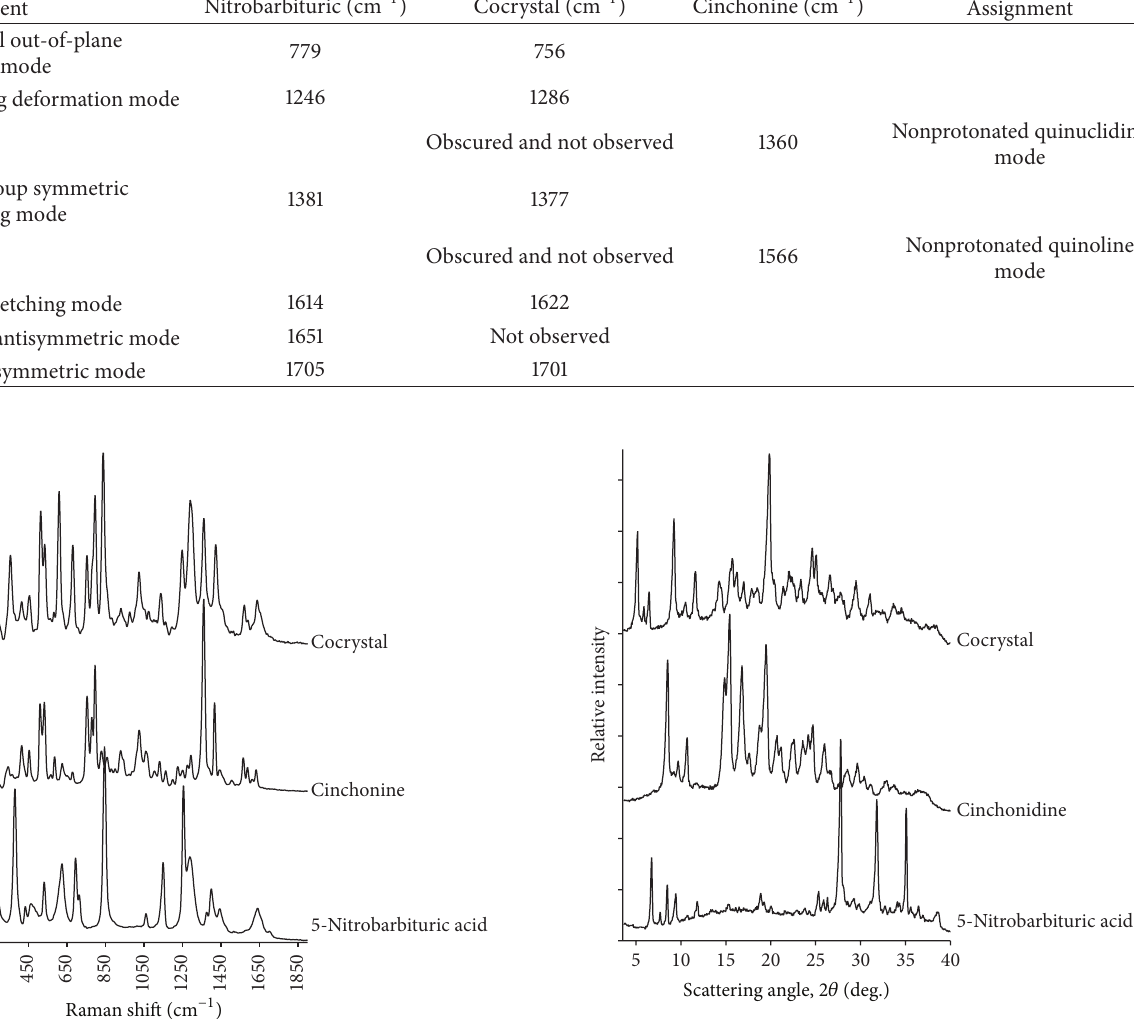
Figure 5: Raman spectra within the fingerprint region of 5-nitro- barbituric acid, cinchonine, and the 1:1 nitrobarbituric-cinchonine